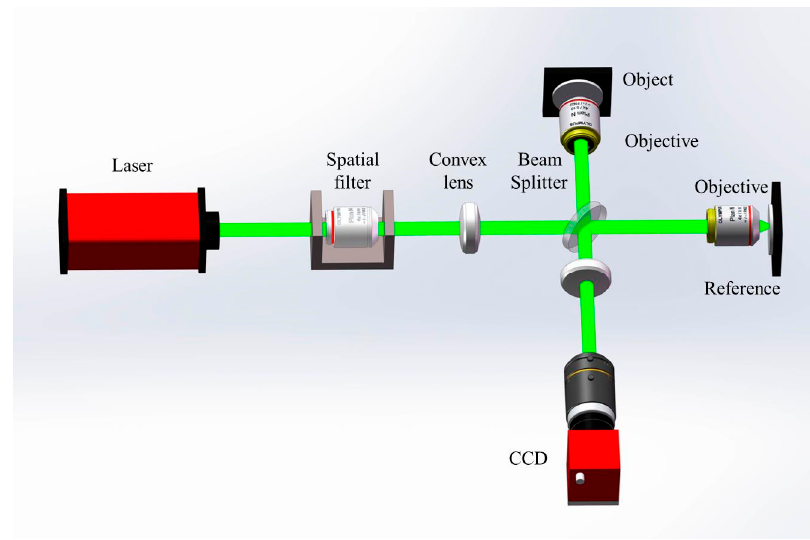
Figure 1. The diagram of Linnik microscopic interferometry